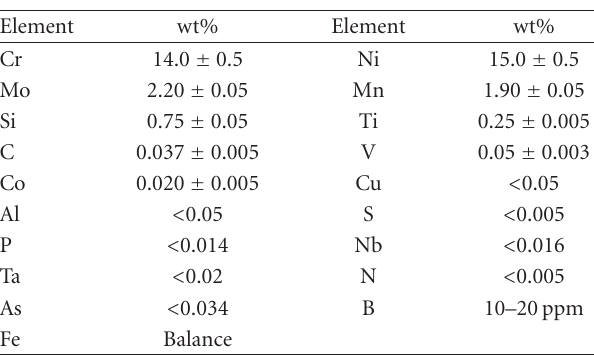
Table 1: D9 composition (in weight